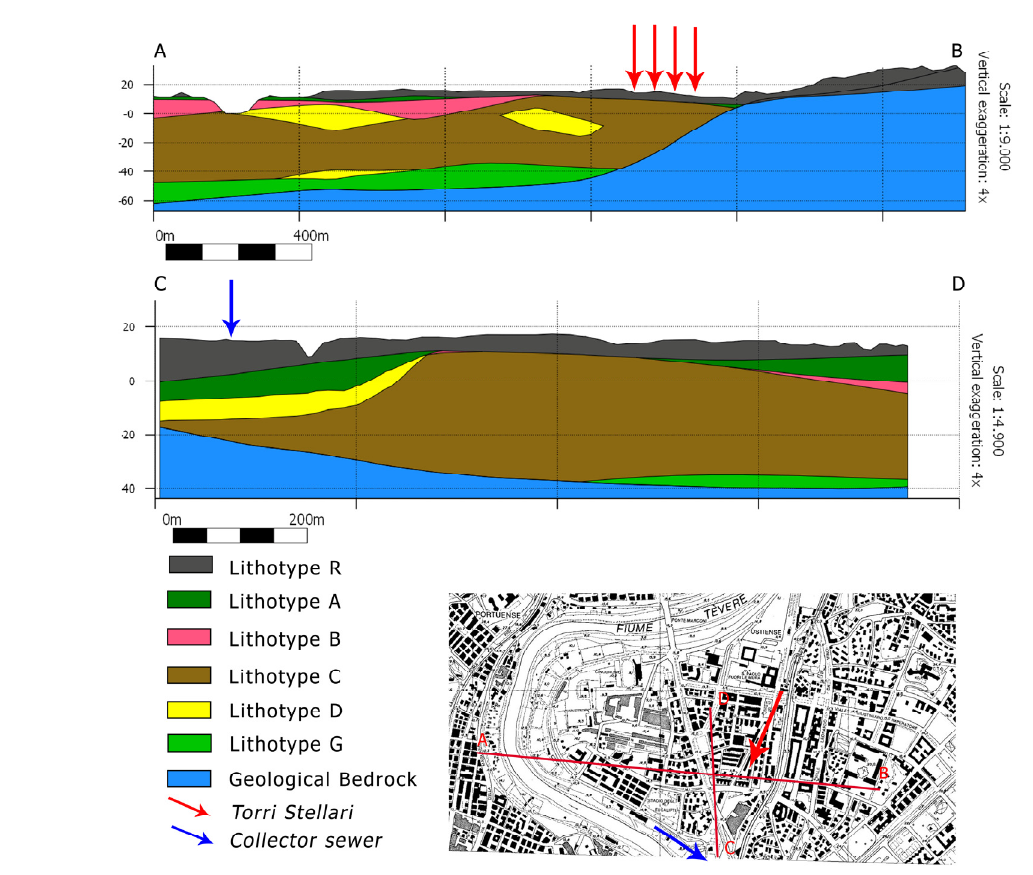
Figure 9. Cross-sections of the 3D geological model: ( a ) section A, B; ( b ) section C, D; ( c ) topographic map with traces.